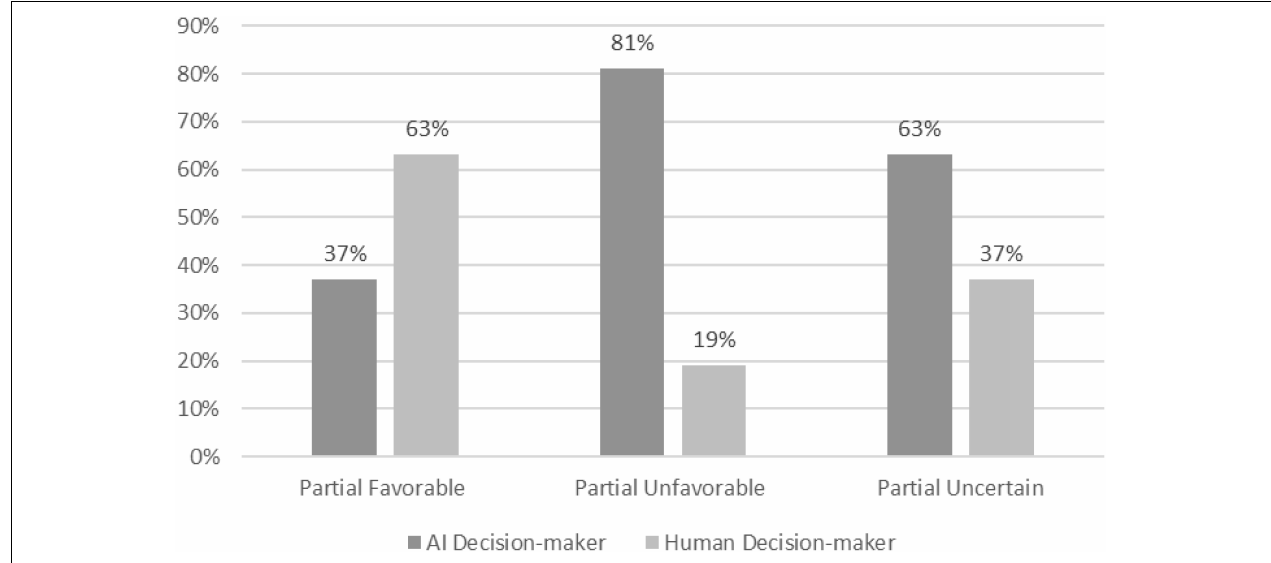
FIGURE 1 | Preferences for AI decision-makers in favorably biased, unfavorably biased and uncertain conditions (Study 2). χ 2 (2), ( N = 369) = 60.88; p < 0.001. best students, irrespective of demographic factors such